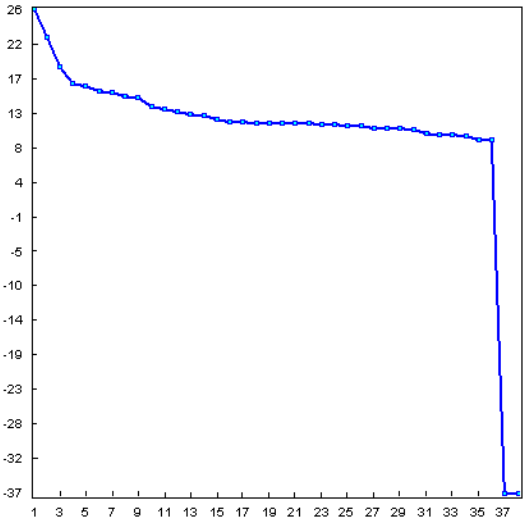
Figure 7. Logarithms of the 38 eigenvalues.